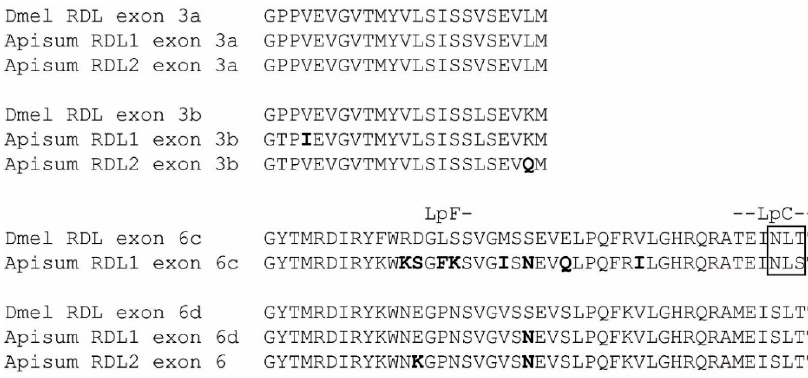
Figure 3. Splice variants of A. pisum and D. melanogaster RDL. Alternative splicing of exons 3 and 6. Acyrthosiphon residues that differ from those of the orthologous Drosophila exon are highlighted in bold. N -glycosylation sites are boxed and Loops C and F, which contribute to ligand binding, are indicated.